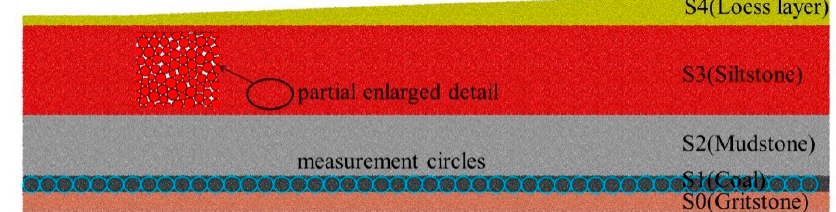
Figure 3. Numerical model.